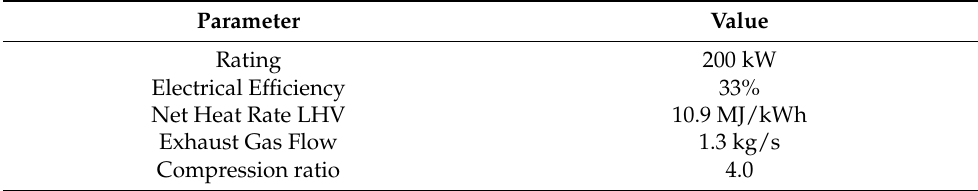
Table 5. Capstone C200 microturbine datasheet